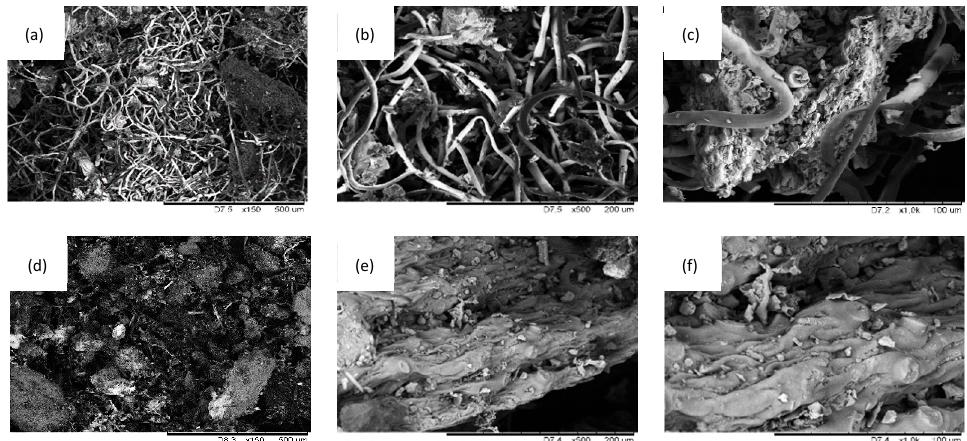
Figure 2. Morphological structure of ( a – c ) SO filler, and ( d – f ) MMT-modified SO filler.